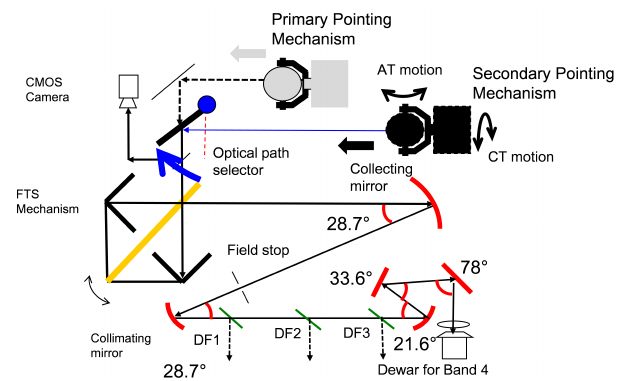
Figure 4. Pointing mechanisms and optics layout of